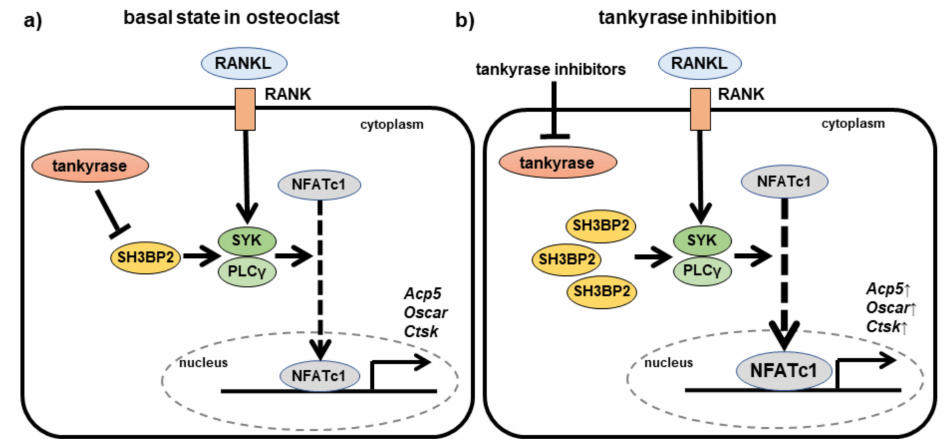
Figure 4. Effects of tankyrase inhibitors in osteoclasts. ( a ) Signaling pathways of osteoclastogenesis in physiological conditions. SH3BP2 transduces osteoclast-inducing signaling pathways as an adaptor protein downstream of RANK. Tankyrase regulates expression of the SH3BP2 protein. ( b ) In the presence of tankyrase inhibitors, the SH3BP2 protein accumulates in the cells in the absence of the tankyrase-mediated degradation process. Accumulated SH3BP2 enhances activation of SYK and PLC γ downstream of RANK, resulting in enhanced osteoclastogenesis, represented by increased expression of osteoclast-associated genes, such as Acp5 , Oscar , Ctsk . A solid arrow indicates direct stimulatory modification, a blunt-ended arrow indicates direct inhibitory modification, and a dashed arrow indicates translocation of the protein. RANKL, receptor activator of NF- κ B ligand; RANK, receptor activator of NF- κ B; SYK, spleen tyrosine kinase, PLC γ , phospholipase C gamma; NFATc1, nuclear factor of activated T-cells, cytoplasmic 1; Acp5, acid phosphatase 5; Oscar, osteoclast-associated receptor; Ctsk, cathepsin